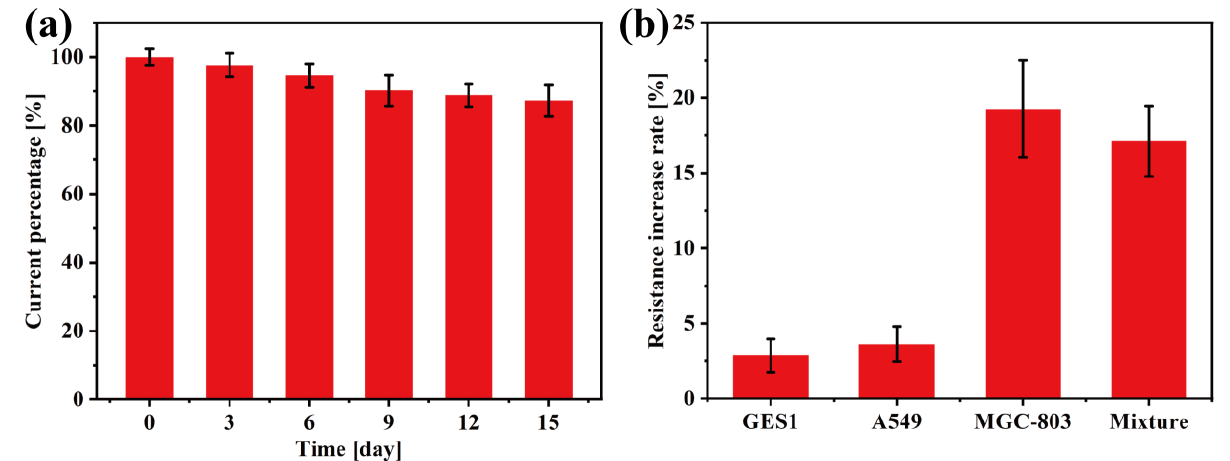
Figure 6. ( a ) The change in the current value of GO-AuNSs@rBSA-FA-labeled electrodes with time. ( b ) The resistance increase in GO-AuNSs@rBSA-FA-labeled electrodes modified with different cells and their mixtures.